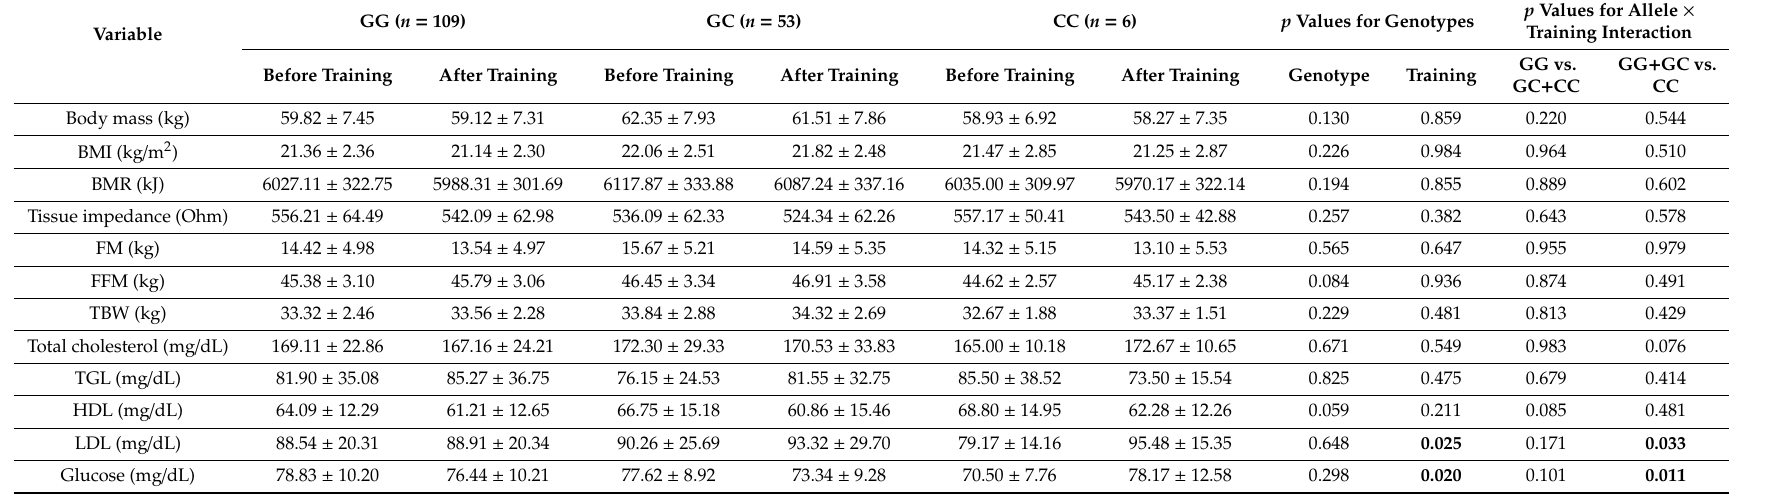
Table 1. The PPARA I7 rs4253778 genotypes and response to